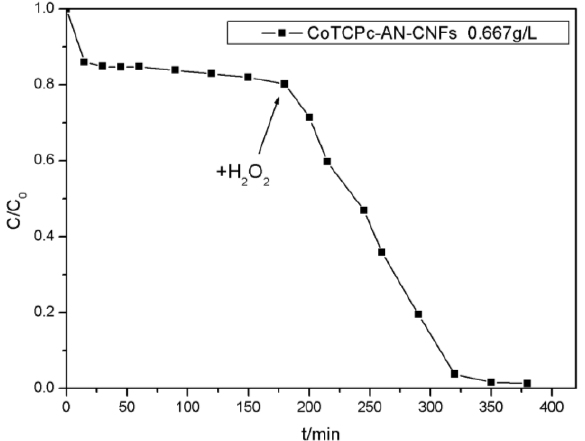
O after dynamic equilibrium [ C (AO7) = 5.00 × 10 −5 mol/L, 2 2